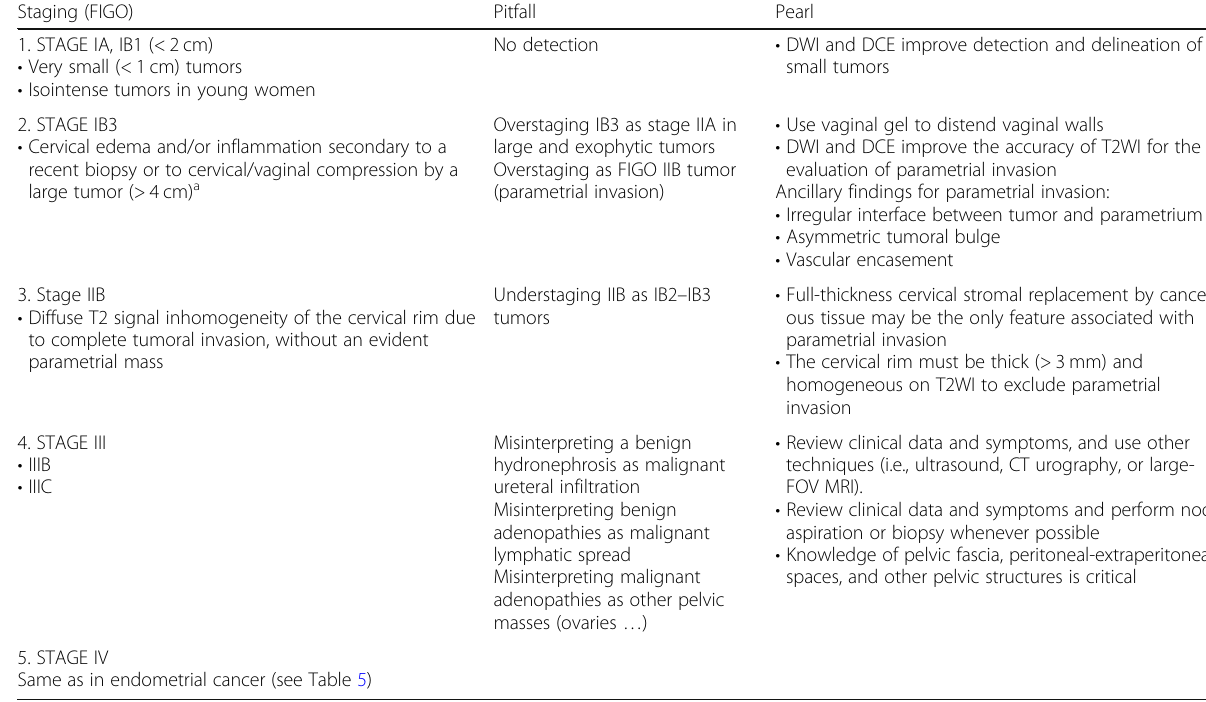
Table 6 MRI in cervical cancer staging. Pitfalls and pearls Staging (FIGO) Pitfall Pearl